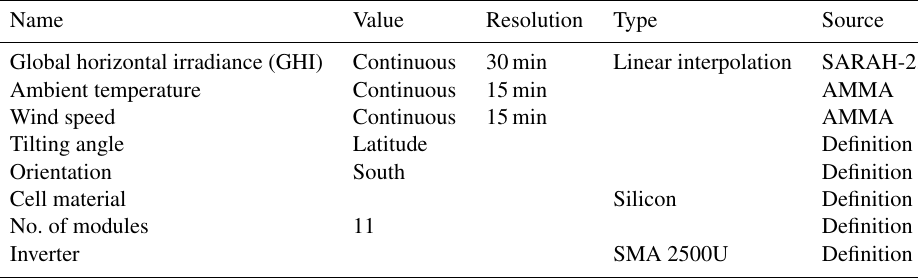
Table 2. Input data for photovoltaic power calculations.